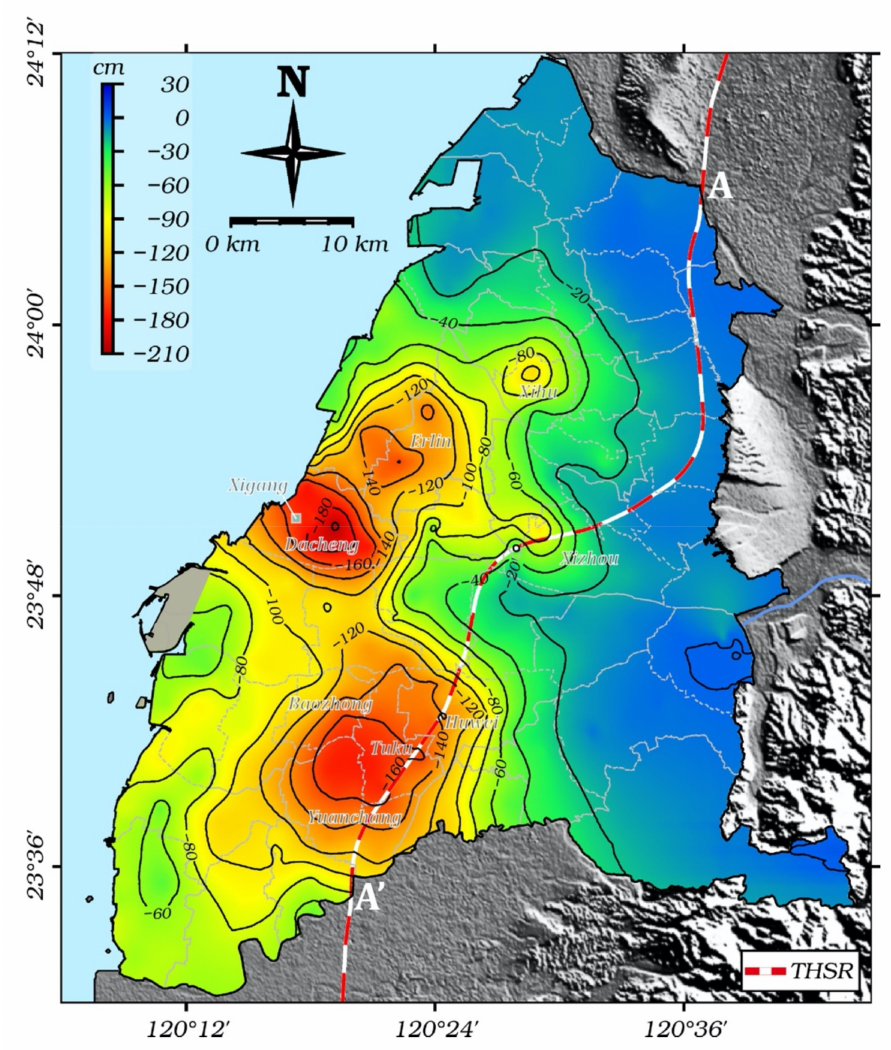
Figure 4. Cumulative land subsidence values in the CRAF from 1993 to 2019. The black line indicates the 20 cm subsidence contours. The value at the coastal bowl-shaped subsidence center (Dacheng Township of Changhua County) is 210 cm and that in the inland center (Tuku Township of Yunlin County) is 180